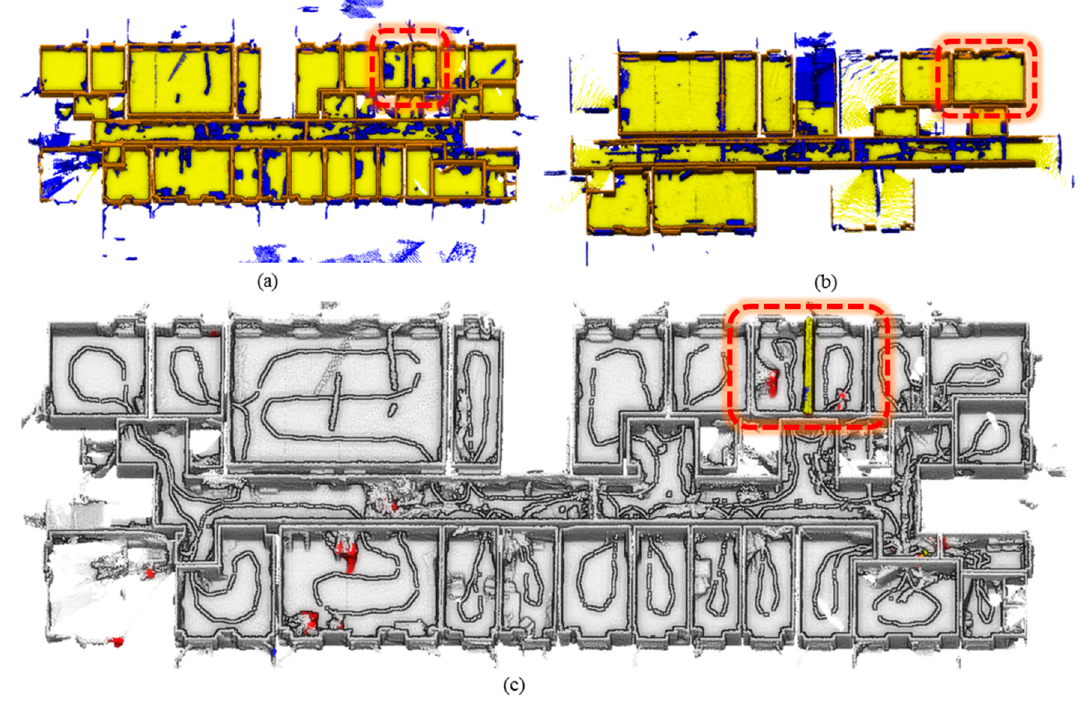
Figure 8. ( a ) PC1 acquired by a backpack and ( b ) PC2 is acquired by Zeb-Revo, walls (orange), floor (yellow), clutter (blue). ( c ) The changes are detected in PC1 and classified to permanent structure changes (yellow) and non-permanent changes (red). The red rectangle shows the wall that is showing a permanent change.